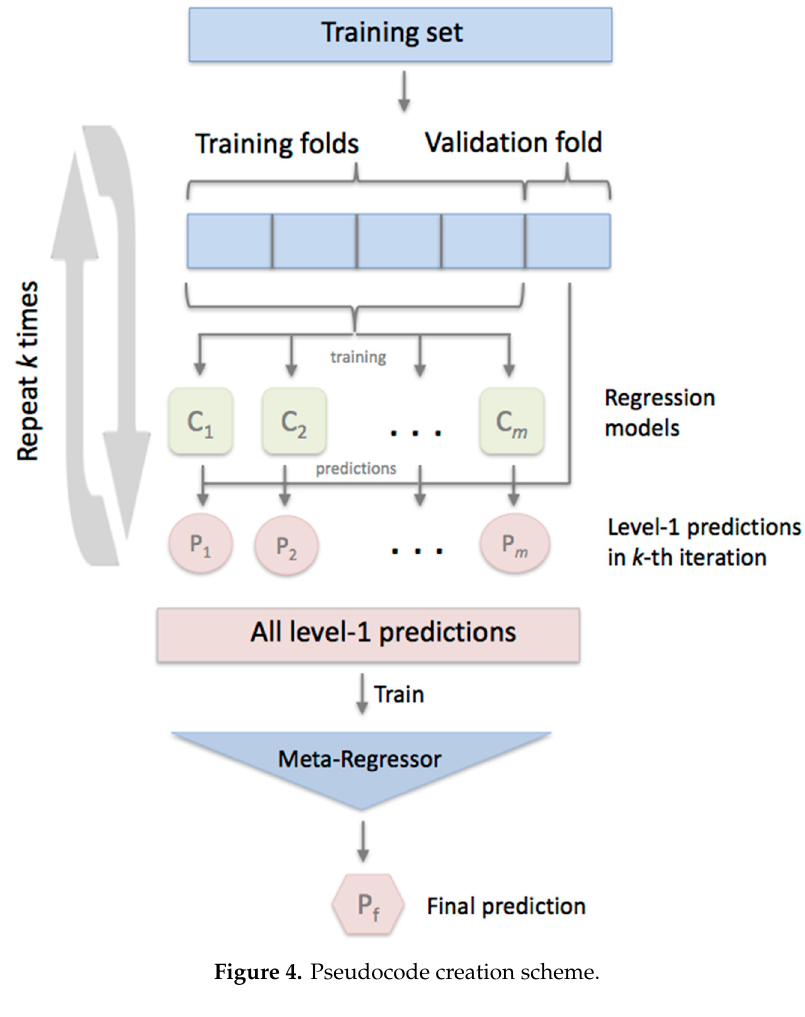
Figure 4. Pseudocode creation scheme. Appl. Sci. 2020 , 10 , x FOR PEER REVIEW